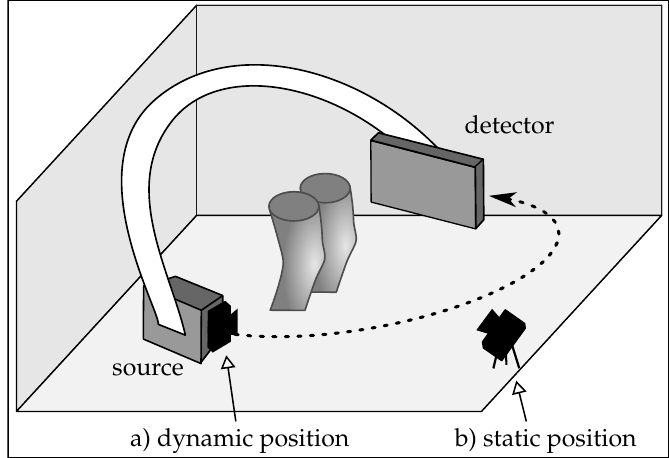
Figure 1. Schematic scene of the acquisition scenario. During scanning, the C-arm rotates around the object and acquires projections. At the same time, a range camera observes the scene. Possible camera positions investigated in this work are either dynamic ( a ) or static ( b ).